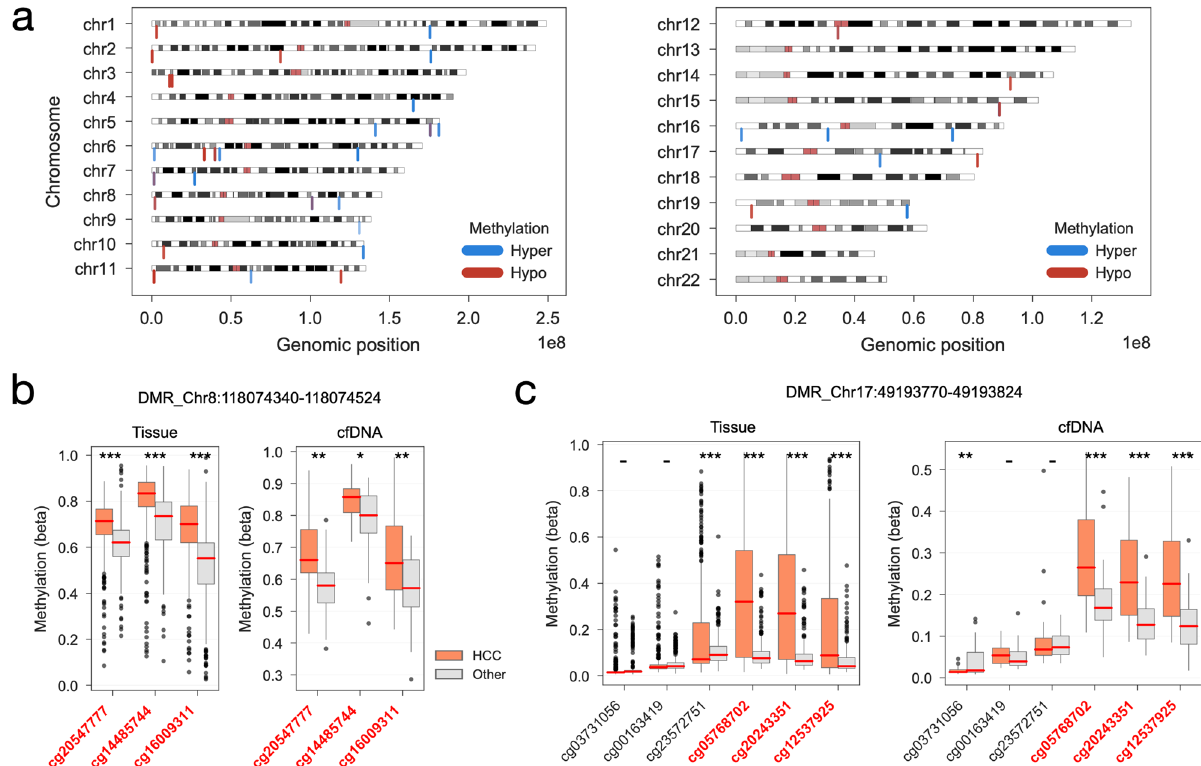
Figure 3. HCC DNA methylation biomarkers. ( a ) genomic localisation of the significantly differentially methylated CpG sites contained in the top 38 DMRs. Blue represents hypermethylation and red hypomethylation in HCC. ( b ) Top recurrent DMR in the optimal LinearSVC models. Distribution of DNA methylation (beta) of CpG sites contained within 1000 base-pairs up/down-stream of the DMR. In red are labeled CpG sites that are contained in the DMR. DNA methylation is split and coloured by HCC and the rest. Left panel shows the methylation of all tissue samples in the Train & Test dataset, and right-hand side the DNA methylation of cfDNA HCC, cirrhotic and healthy samples. Above the plots are reported the DMR associated chromosome and genomic coordinates. ( c ) similar to ( b ), instead showing the distribution of a representative DMR that is highly predictive of HCC in both tissue and cfDNA samples. *, ** and *** denotes significant at P < 0.05, P < 0.01 and P < 0.001 by unpaired t-test, respectively, and ‘-’